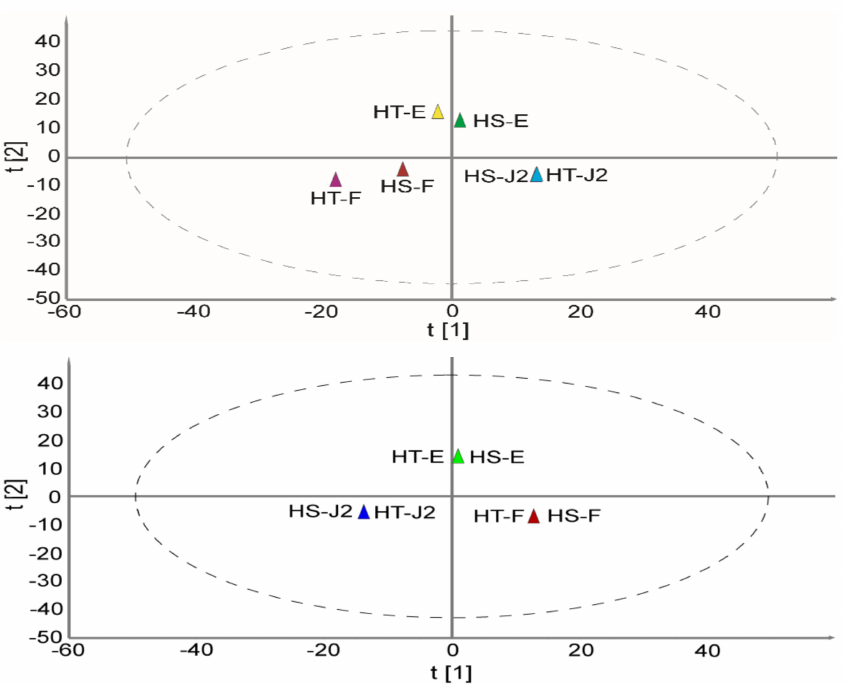
Figure 3. Score plots of the principal component analysis (PCA) ( top ) and orthogonal partial least squares discriminant analysis (OPLS-DA) ( bottom ) of H. schachtii and H. trifolii based on the relative peak areas of metabolites. HS-E, H. schachtii egg stage; HS-J2, H. schachtii juvenile 2 stage; HS-F, H. schachtii female stage; HT-E, H. trifolii egg stage; HT-J2, H. trifolii juvenile 2 stage; and HT-F, H. trifolii female stage. Table 2. Comparison of the relative peak areas of metabolites between H. schachtii (HS) and H. trifolii (HT). Metabolites with No Significant Difference Metabolites Significantly Higher Metabolites Significantly Higher Stage between HS and HT in HS than HT in HT than